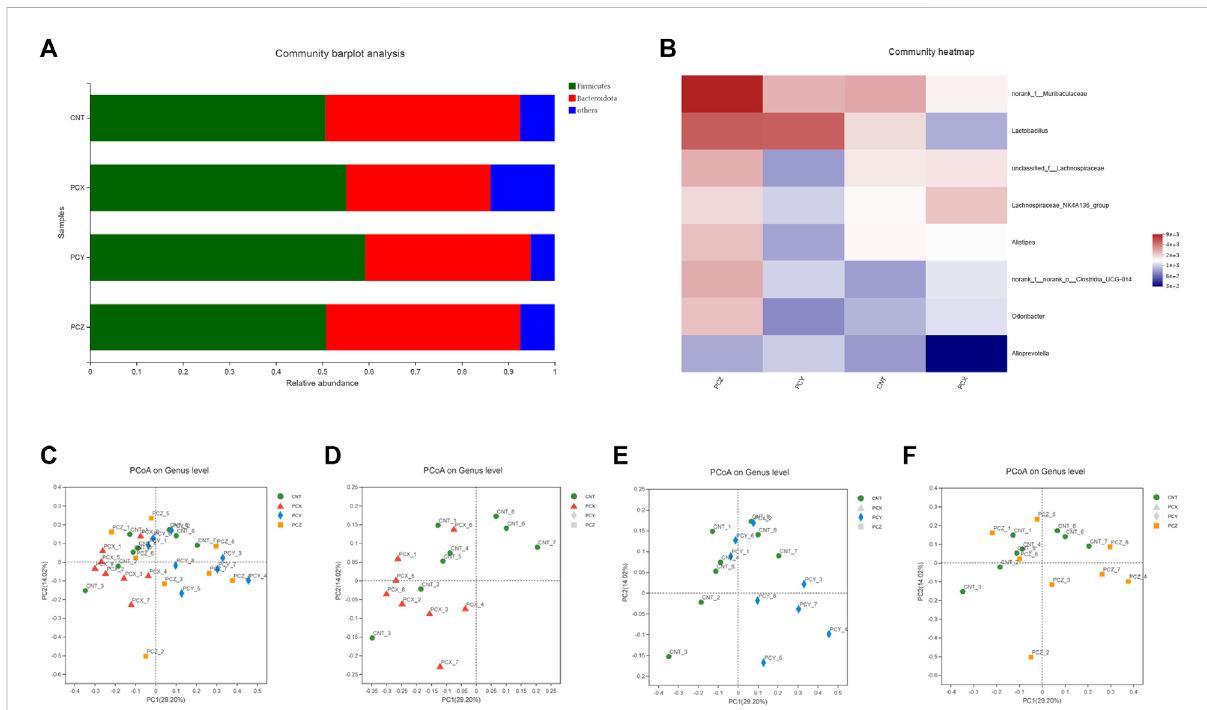
FIGURE 2 (A) Bacterialtaxonomicdistributionsin16SrDNAsequencingdatafrommousefecesatthephylumlevel. (B) Heatmapoffecalmicrobiotaatthe genus level. (C) Score scatter plots of the PCoA classi fi cation of fecal microbiota of four groups together. (D) Score scatter plots of the PCoA classi fi cation offecal microbiota in thePCX and CNT group. (E) Score scatter plots ofthePCoA classi fi cation offecal microbiota in thePCYand CNT group. (F) Score scatter plots of the PCoA classi fi cation of fecal microbiota in the PCZ and CNT